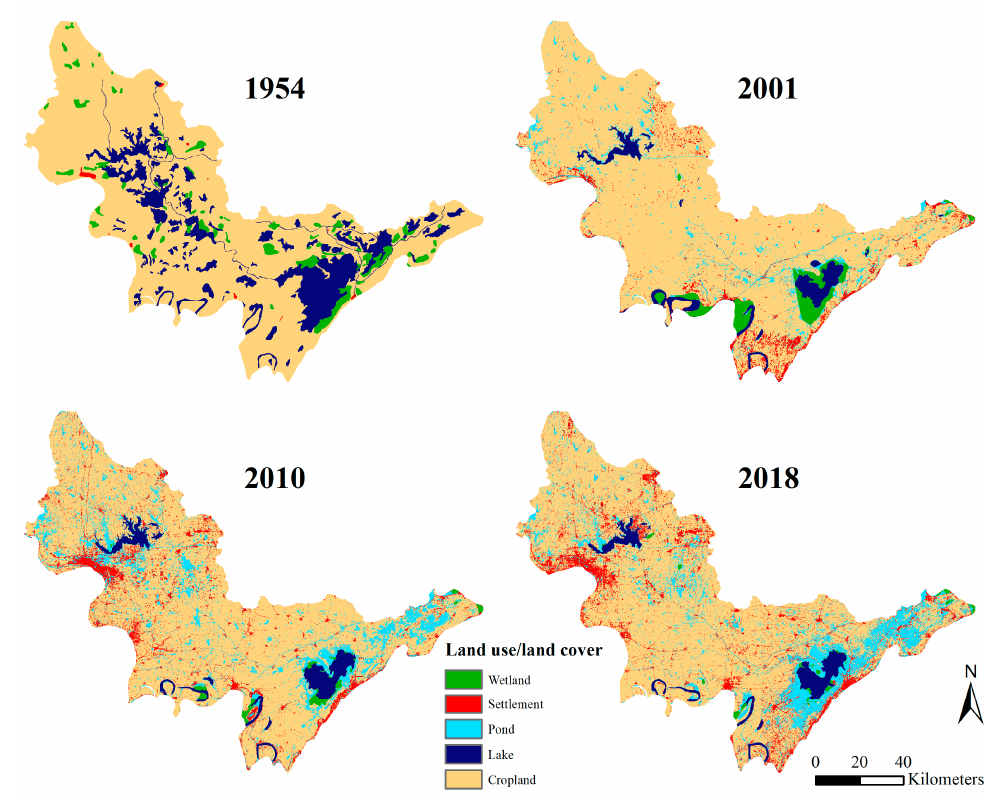
Figure 2. The land use/ land cover in different years (1954, 1983, 2001, 2018).